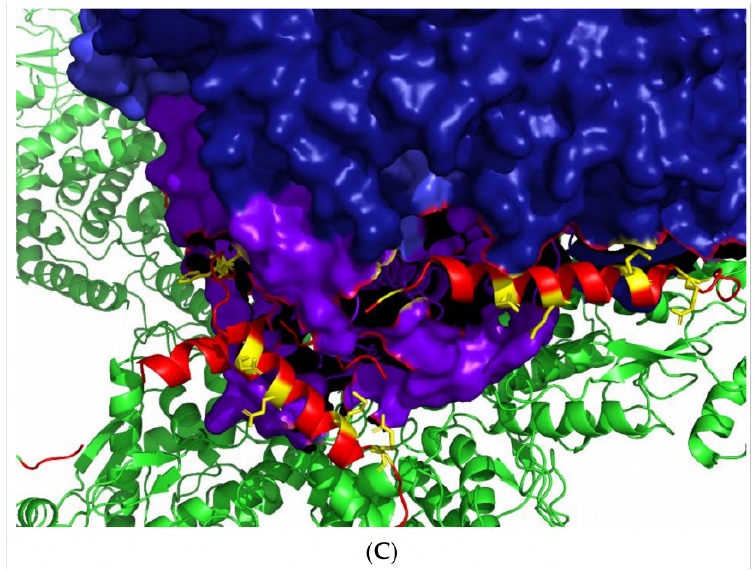
Figure 7. The RdRPs of Reoviridae. ( A ) The figure shows the RdRP domain of CPV in the quiescent stage with the bound RNA during transcription. The template (yellow), non-template (pink), and transcript (orange) RNA are shown as ladders. Modules A (912-1010, light blue) and B (1067-1140, green) from the polymerase (PDB 6TY8, gray surface) are indicated. The noticeable deflection of the module A α -helix (955-1007) of the C-terminal bracelet domain during the elongation stage (PDB 6TZ2, purple ribbon) is evident. ( B ) The in situ structure of rotaviral RdRP. The RdRP of Rotavirus at transcript-elongated state (blue ribbon, PDB 6OGZ) was superposed on the duplex open state (green ribbon, PDB 6OGY). The marked conformational changes around residues N31-A69, D923-L996, and N1072-D1088 can be observed. The transcript is shown in orange and the template strand in yellow. ( C ) The in situ structure of BTV RdRP. The BTV RdRP in its core (PDB 6PO2) shows the disposition of the VP3 (green ribbon) and the RdRP (blue surface). The close interaction of the N-terminal region (red ribbon) of the alternating VP3 with the bracelet domain of the RdRP (purple) around the five-fold axis is believed to be responsible for the activation of the RdRP during infection. E19, D21, and D26 (yellow sticks), three negatively charged residues on VP3’s N-terminal loop, interact with the positively charged region of the bracelet